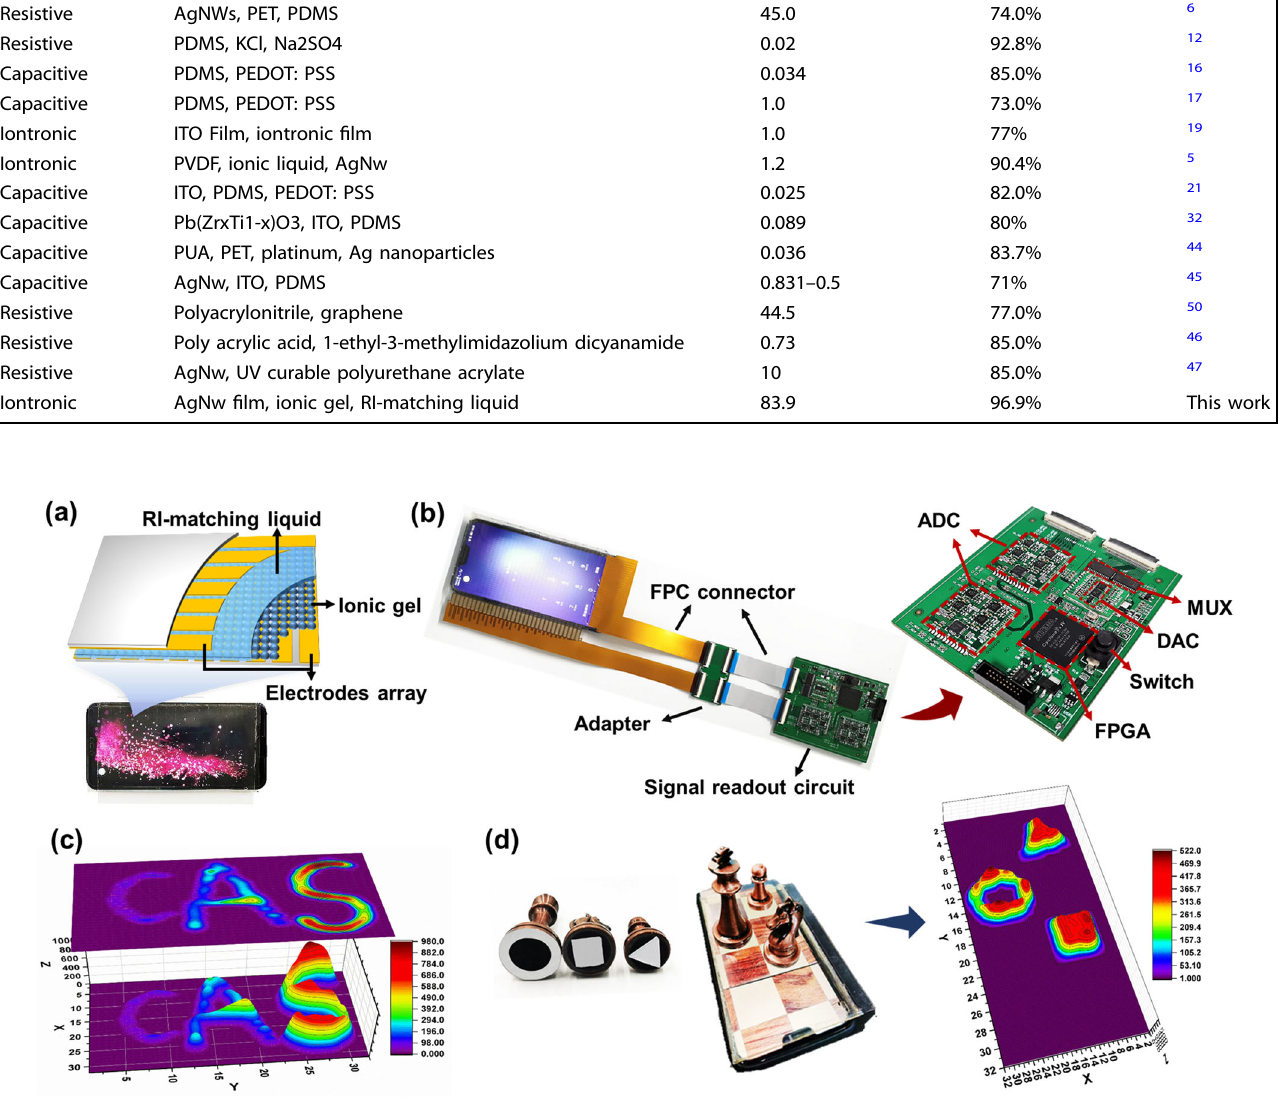
Fig. 5 The demonstration of transparent tactile AI. a The TIS touchscreen with a 32 × 32 sensing array attached on the screen, and the structural schematic diagram of the TIS array, b the TIS touchscreen system and the design of the signal readout circuit c the captured pressure heat map when writing “ CAS ” with a fi nger on the screen, d a typical application scenarios of object recognition using TIS touchscreen: virtual chess game on a displaying device using real pieces.